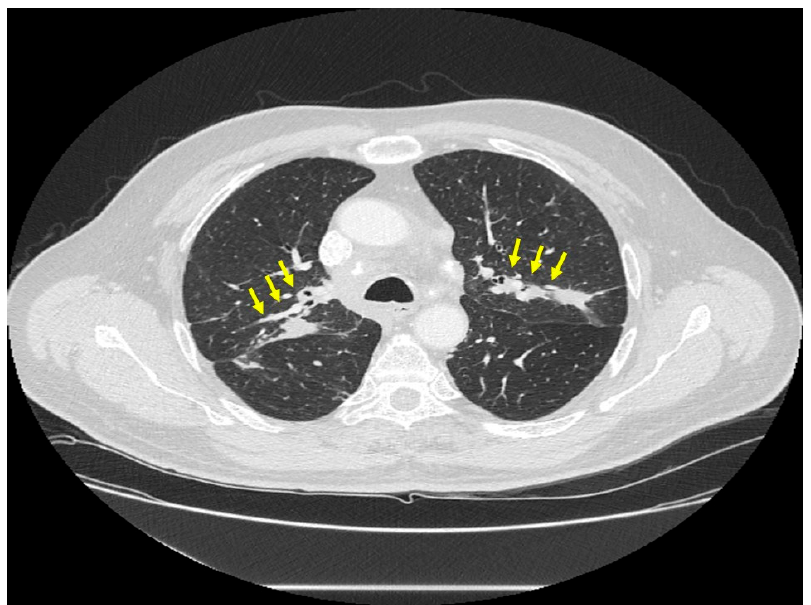
Figure 2. Chest CT scan image of a patient with pulmonary sarcoidosis, demonstrating lung opacities from granulomatous inflammation around airways (arrows).